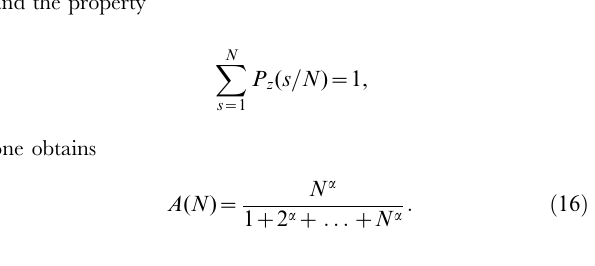
Figure S1 Rescaled cluster size distributions for time-shuffled data do not collapse. A. Unscaled PMFs of time-shuffled cluster sizes for different system sizes in the high-density array of monkey Y ( N = 11, 22, 45, 91). B. Renormalized PMFs assuming a power law distribution, i.e., P ( s ) ? P ( s )/ A ( N ) with A ( N ) ~ N a = (1 z 2 a z .. . z N a ) (Eq. 16). C. Renormalized PMFs assuming the exponential distribution with A ( N ) ~ 1 = ( e { l = N z e { 2 l = N z ... z e { l ) (see Supporting Information, Text S1). Cluster sizes in B and C were normalized by the system size N (indicated by the gray arrows at unity). Figure S2 Parameter estimation for the original and the time- shuffled data in two data sets (monkey X and Y). A. Power law model with slope parameter a . B. Exponential model with parameter l . Three different estimation methods were compared: LS least-square estimation, KS Kolmogorov-Smirnov statistic, and ML maximum likelihood estimation. Note that all estimation methods yield similar estimates for the power law fit of the original distributions and the exponential fit of the time-shuffled distribu- tions. However, LS estimation gave largely different values compared with KS and ML estimation when the original distribution was fitted by an exponential model, or when the power